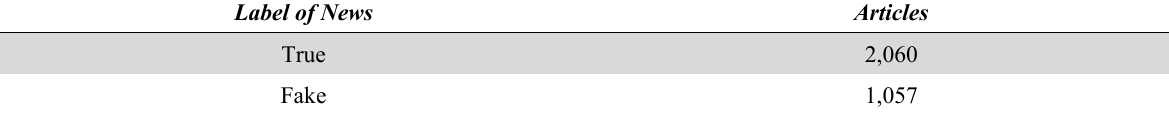
The characteristics of the COVID-19 fake news dataset Label of